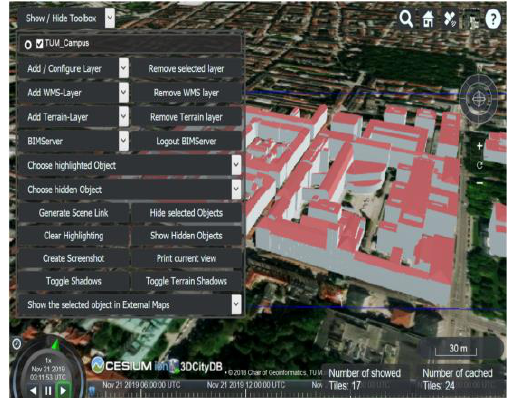
Figure 7: 3D Web client Toolbox with the BIMserver